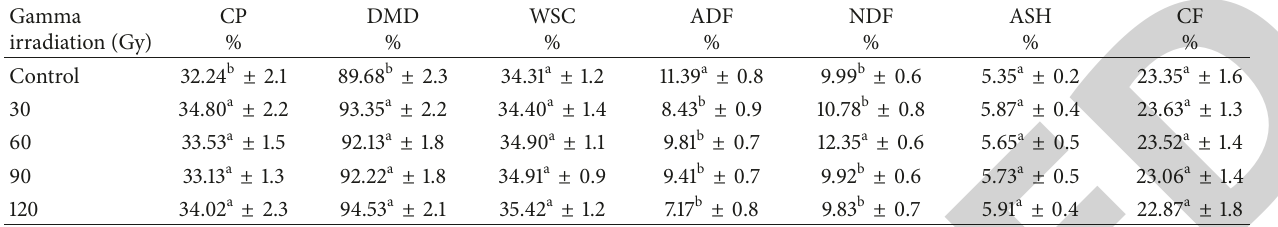
Table 3: Mean comparison of nutritional traits among irradiated and non-irradiated O. viciifolia seeds.